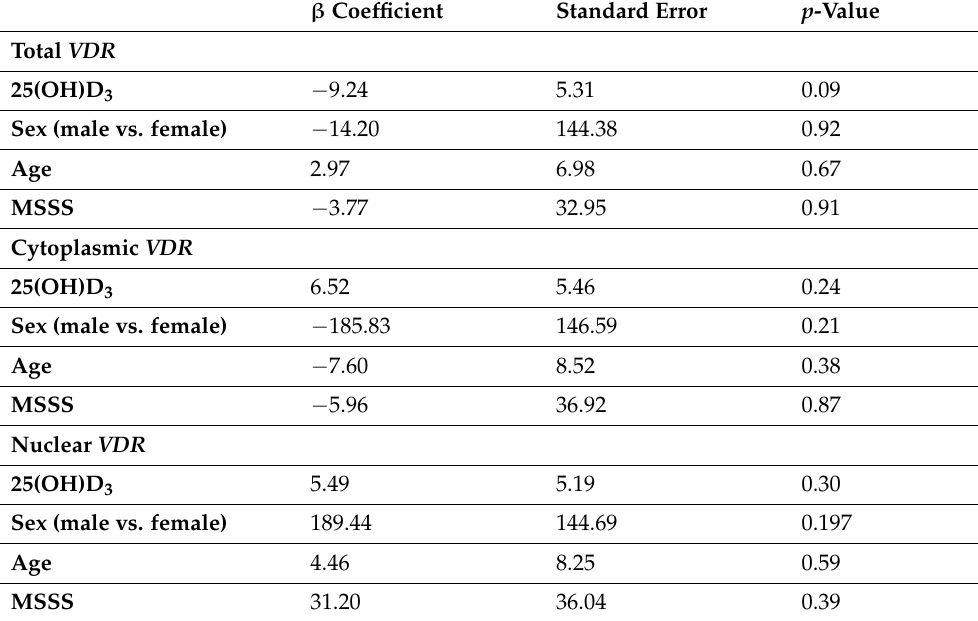
Table 4. Total, cytoplasmic and nucleic VDR protein expression levels related to 25(OH)D 3 plasma levels in MS patients. β -Coefficient and standard error of analyzed factors are derived from a linear regression model. p < 0.05 is considered statistically significant. β Coefficient Standard Error p